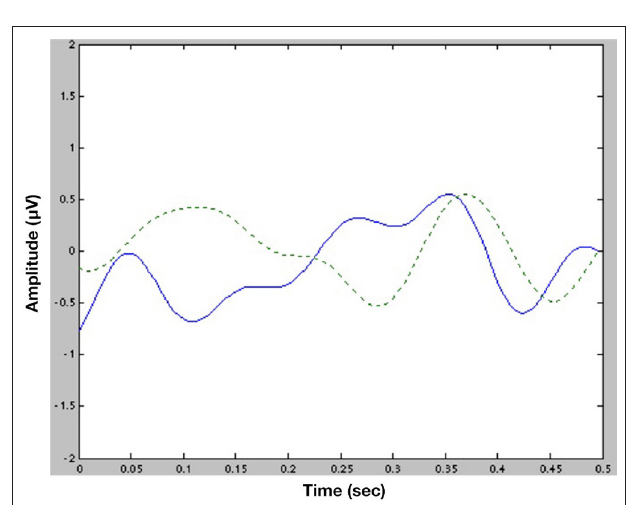
FIGURE 4 | Average ERP traces (experimental minus control) at Cz for subjects with a positive behavioral effect ( µ = 2.5; N = 10; solid line) vs. for subjects with a negative behavioral effect ( µ = − 3.1; N = 19; dotted line). The higher the difference between experimental and control at N320, the more phonological choices ca. 1s after the